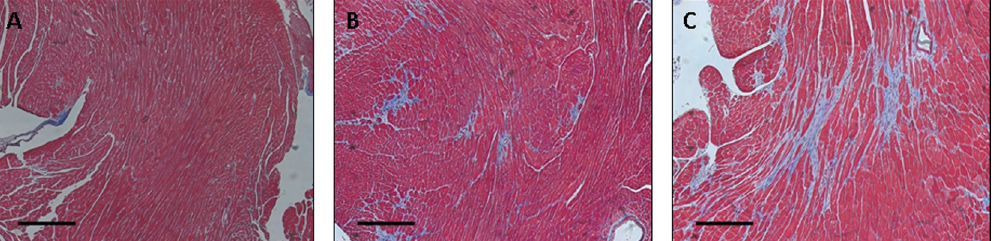
Figure 3. Histologic examination with Masson’s trichome staining of myocardial tissue is shown for representative mice from each of the 3 animal groups. : control (Panel A), debanded (Panel B), and banded (Panel C). The black horizontal scale bars represent 50 micrometers.